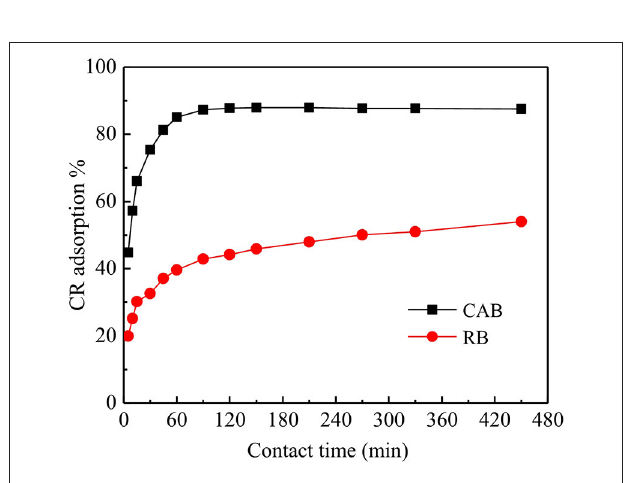
FIGURE 2 | Effect of adsorbent dosage on CR adsorption on RB and CAB.